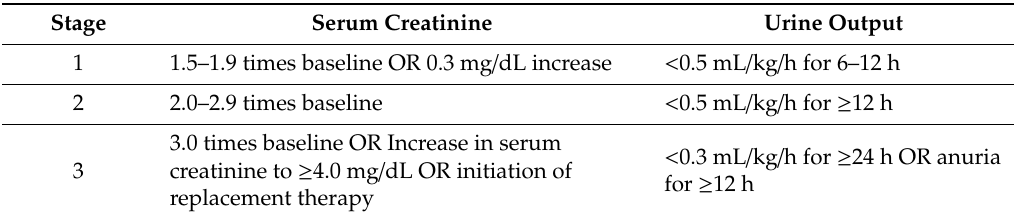
Table 1. KDIGO criterion for diagnosis and staging of AKI